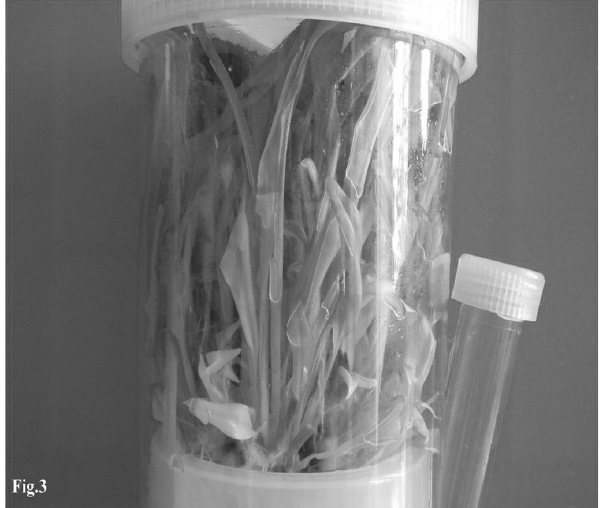
Fig. 3: High frequency microrhizome production using growtek in MS liquid medium supplemented with 8% sucrose, 1 mg L -1 NAA and 4 mg L -1